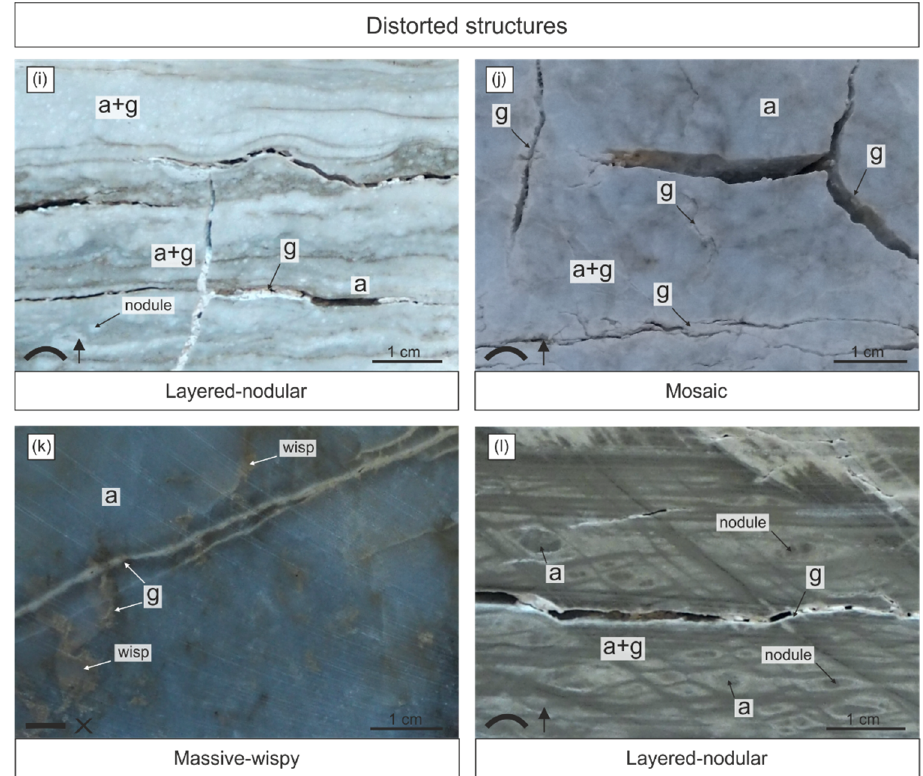
Figure 5. Typical structures of rocks of the anhydrite weathering zone at Dingwall ( a – l ) seen on cut surfaces (according to classification by Maiklem et al. [55], modified and supplemented). Signs in lower left side of the photos: straight line–sample collected from undisturbed rock layer from the quarry bottom, curved line–sample collected from rock layer composing hydration form; arrow– upward direction relative to the quarry floor, X –view on the surface cut parallel to a horizontal plane. Other signs: a–anhydrite, g–gypsum, a + g–anhydrite and gypsum. Further explanations in the text.